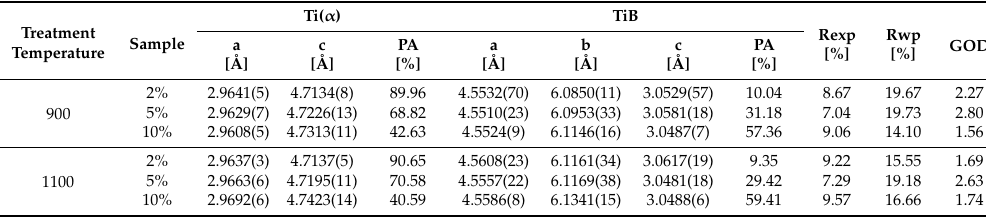
Table 2. Crystallographic data of the composite sinters obtained for different PPS temperature regimes (900, 1100 ◦ C) and starting precursor compositions (2%, 5%, 10%), with the estimation of their phase amount and residual pattern indicators from the Rietveld approach